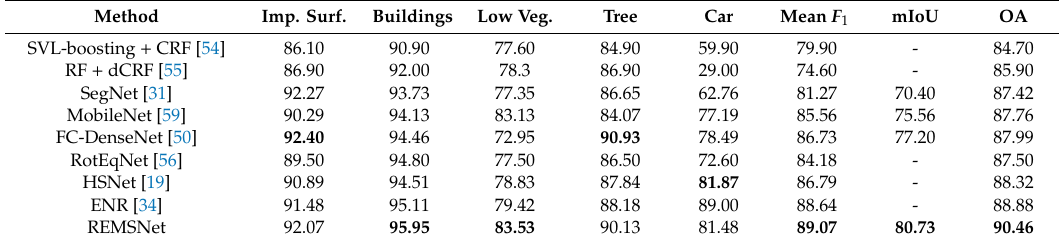
Table 1. Experimental land cover classification results on the Vaihingen dataset (%). The largest land cover classification accuracy is highlighted in bold.